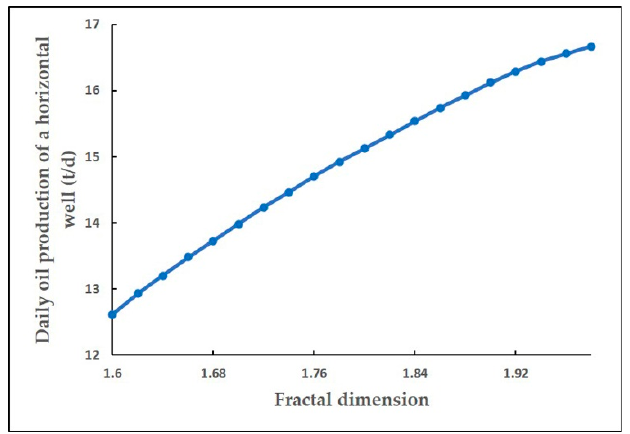
Figure 12. The influence of fractal dimension on horizontal well production.